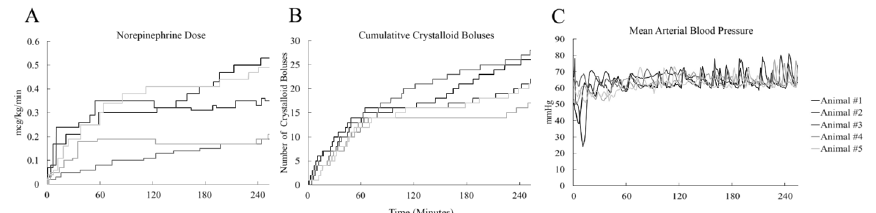
Fig. 4 The norepinephrine dose rate ( A ), number of crystalloid boluses ( B ), and mean arterial pressure ( C ) during the critical care phase